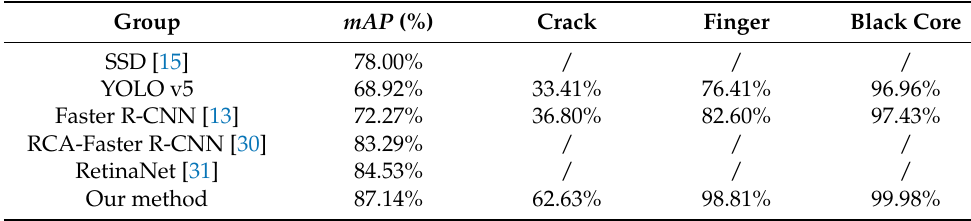
Table 4. Comparison of different